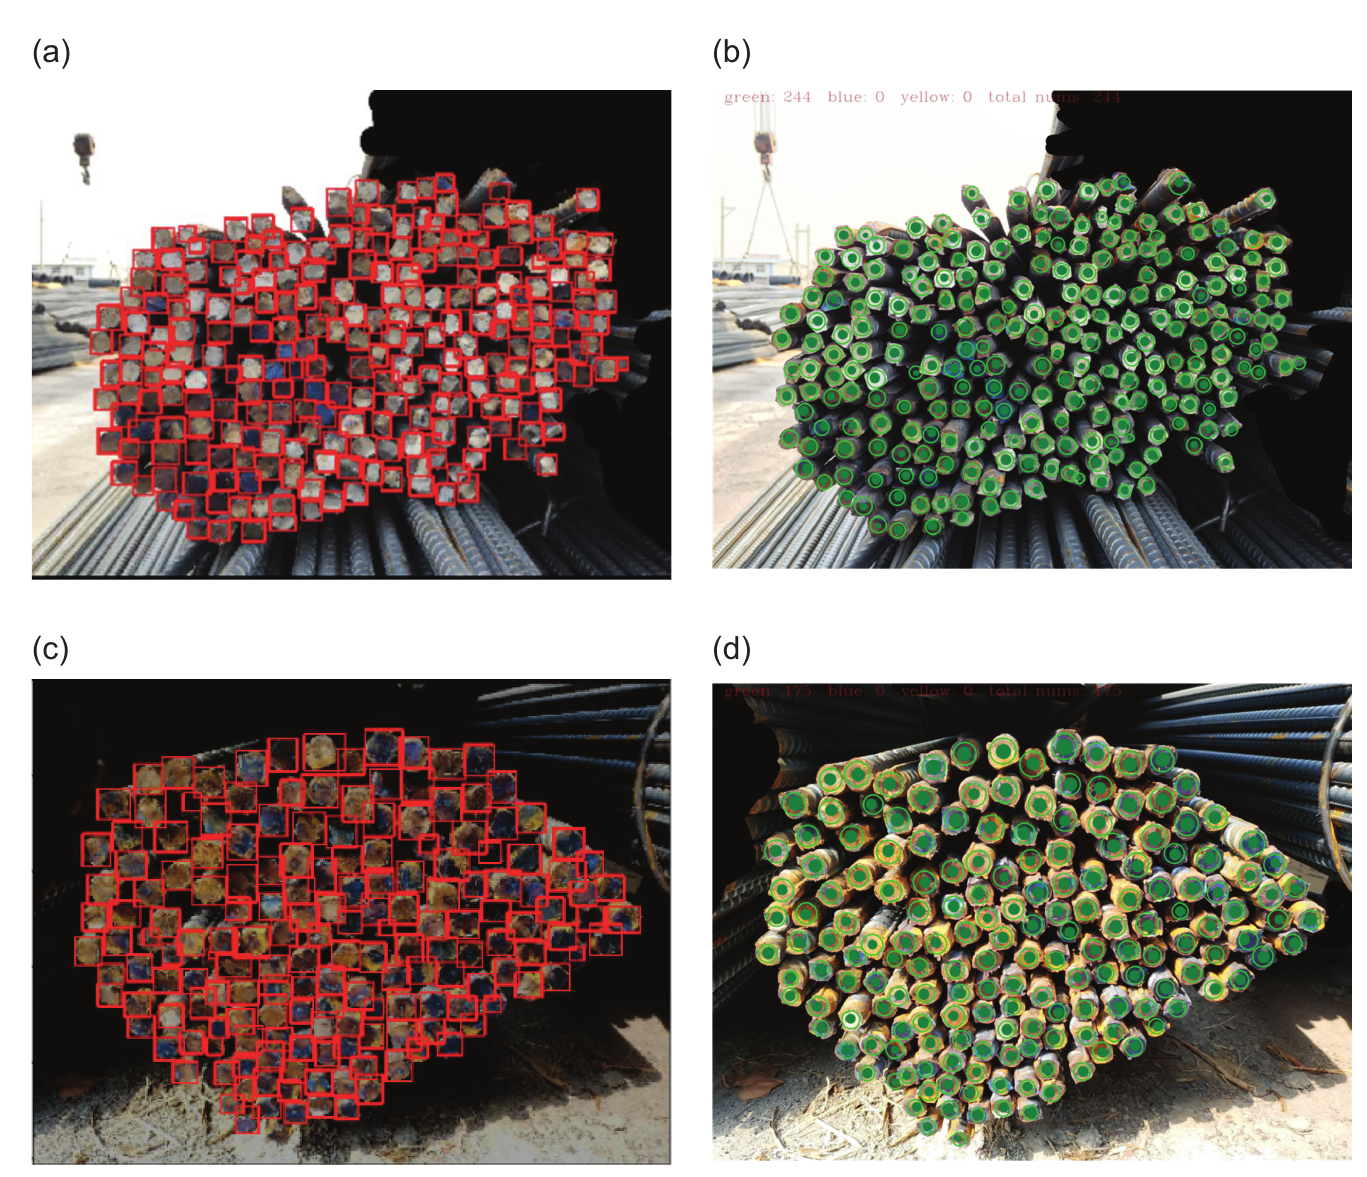
Fig 4. (Color online)Recognition results on two images. (a) and (c) show the results of WSSKP, and (b) and (d) show the results of MaskID.